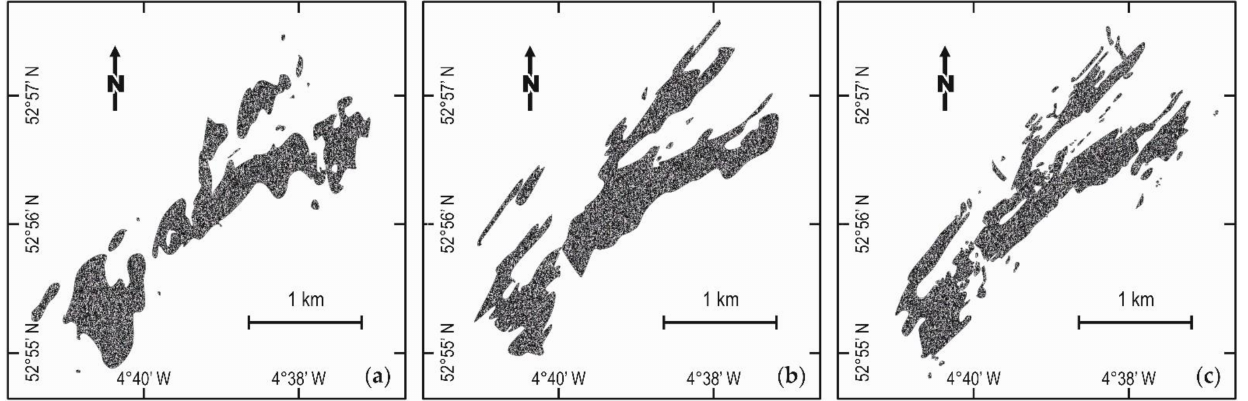
Figure 2. Maps of a Modiolus modiolus reef in the Irish Sea obtained by three different acoustic methods. ( a ) single-beam echosounder (Roxanne TM ); ( b ) multibeam echosounder; ( c ) side-scan sonar (original drawings based on imagery in